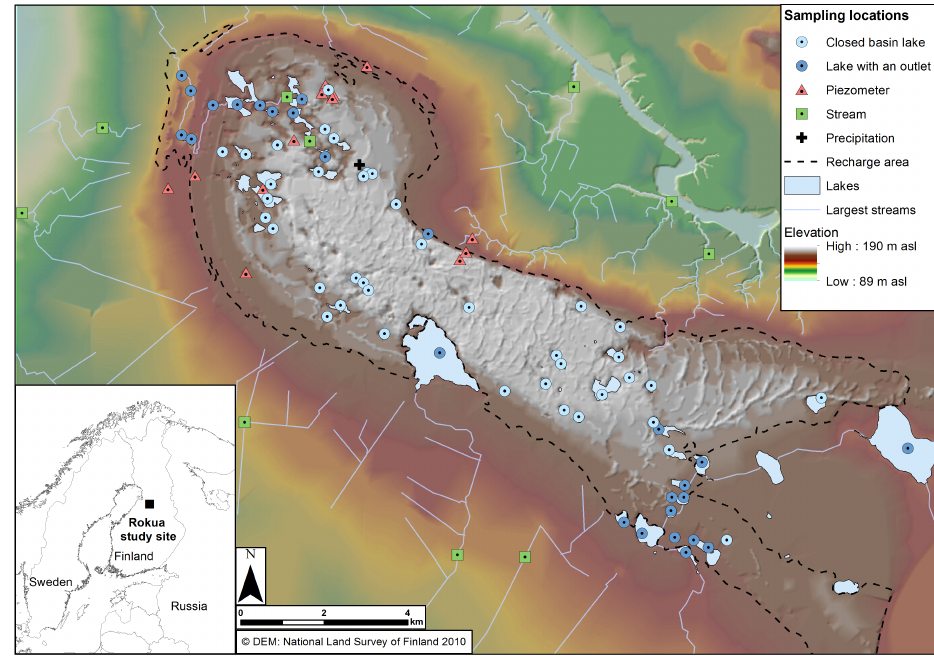
Figure 1. The study site of Rokua esker aquifer area. Digital elevation model by the National Land Survey of Finland (https://tiedostopalvelu.